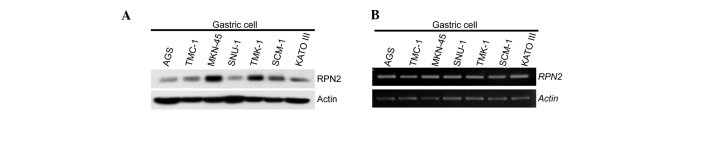
RPN2 expression in the gastric cancer AGS, TMC-1, SNU-1, TMK-1, SCM-1, MKN-45 and KATO III cell lines. (A) The cell extracts were prepared from exponentially growing cells, and extracts containing equal amounts of protein were resolved by SDS-PAGE, followed by western blot analyses using an antibody specific for RPN2. Among these lines, MKN 45 and TMK 1 cells revealed high levels of RPN2 expression at the protein level, whereas AGS and SNU 1 cells exhibited much lower levels of RPN2 protein expression. (B) The RPN2 mRNA levels in each cell line were determined by reverse transcription-polymerase chain reaction using total RNA isolated from cultured cells. RPN2 expression was similar at the transcriptional level in all seven gastric cancer lines.. RPN2, ribophorin II.